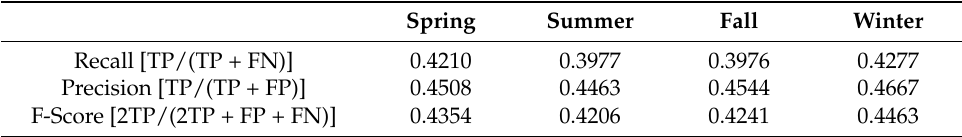
Table 6. Recall, precision and F-Score of the admission diagnosis for aneurysm.